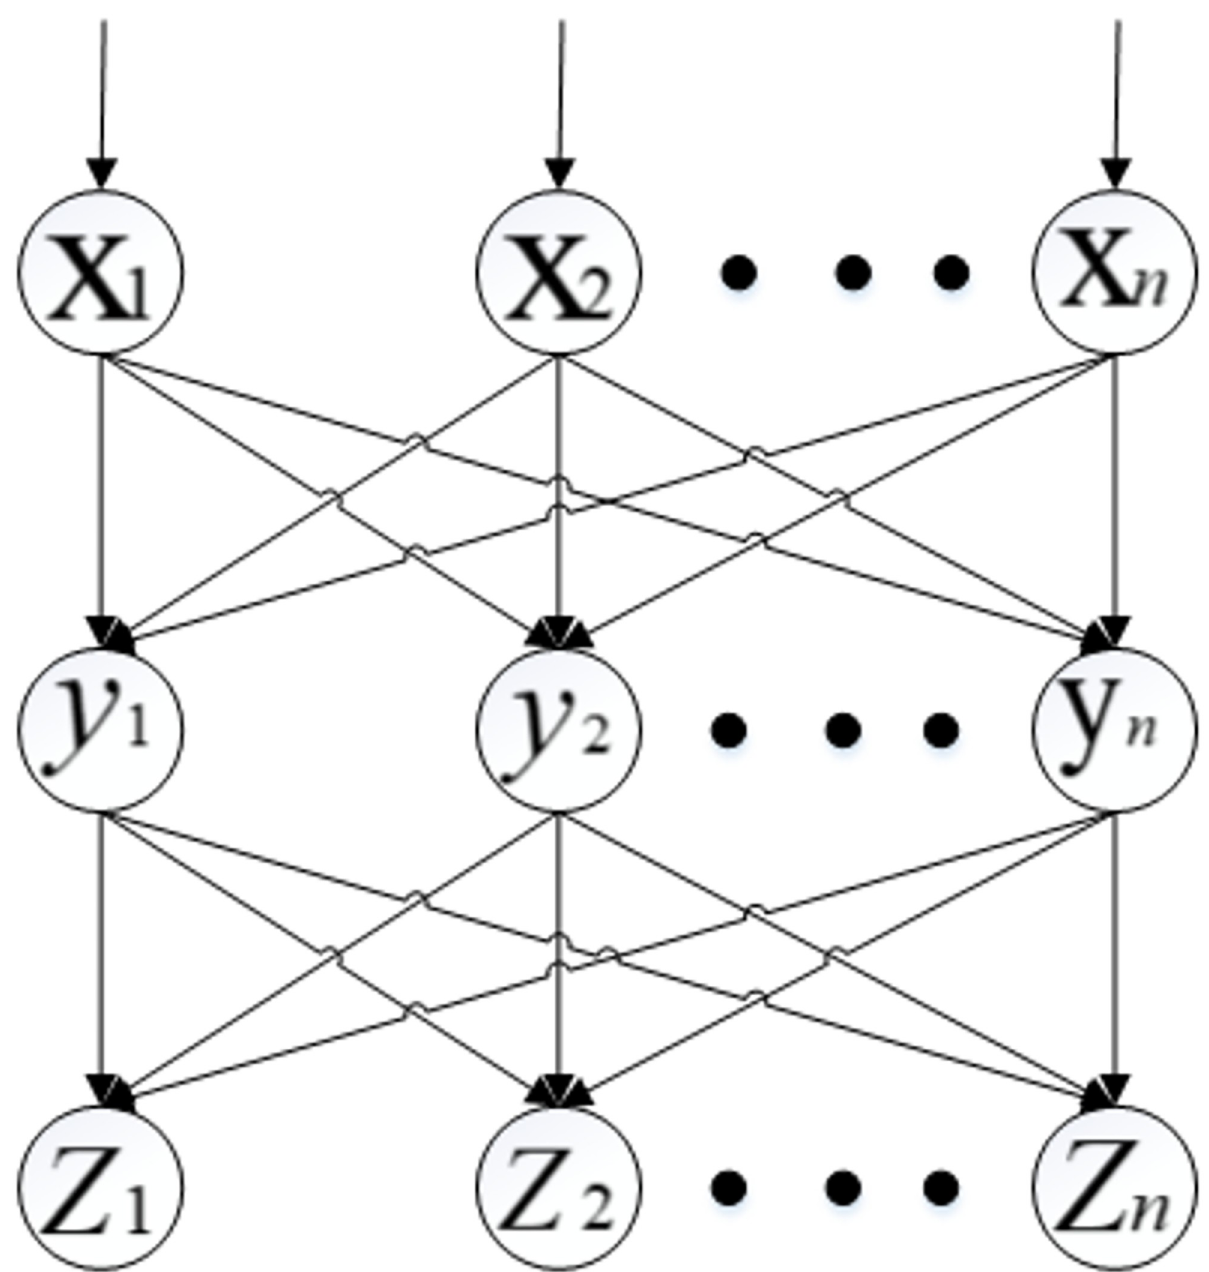
Fig 1. BP neural network model